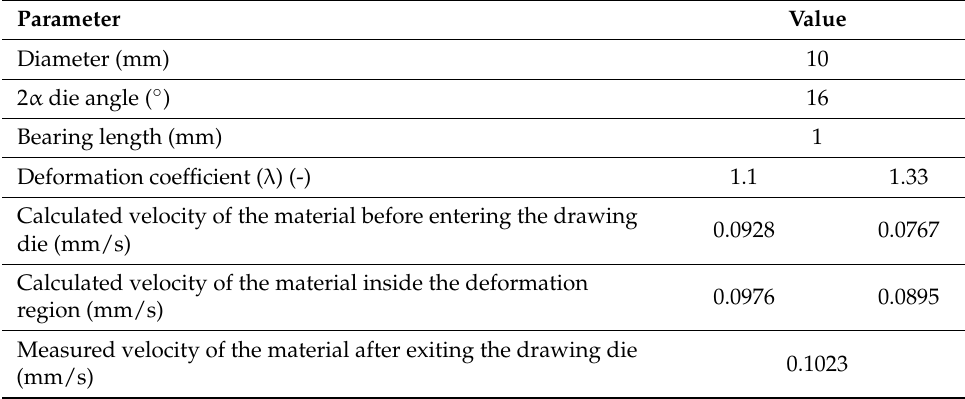
Table 4. Drawing die dimensions along with the deformation coefficient and velocity of the analyzed wire drawing process .